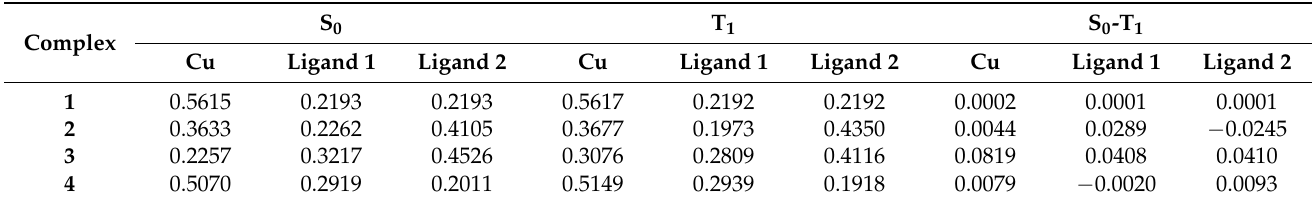
Table 2. Calculated natural population analysis in S 0 and T 1 states (unit in e) by PBE0/[LANL2DZ- ECP/6-31G(d)].